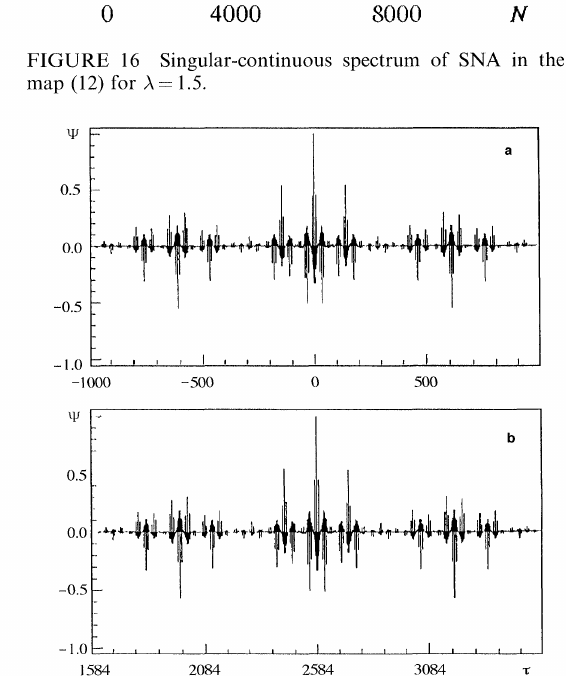
FIGURE 17 Self-similarity of the autocorrelation function of SNA in the system (12). correspondence of the autocorrelation function structure. The plot for (7-) presented in Fig. 17(a) is fully reproduced in Fig. 17(b). This is a con- sequence of the property of scale invariance. The envelop 1(7-)1 in the SNA regime is a decreasing function that tends to some nonzero limit as